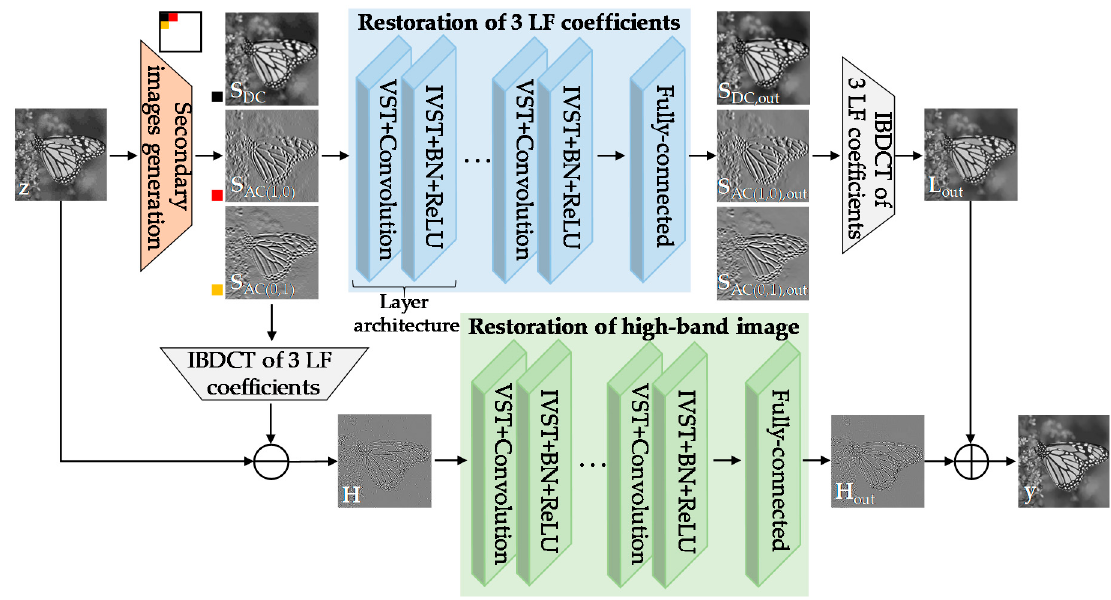
Figure 3. The architecture of the secondary domain intercorrelation enhanced network.